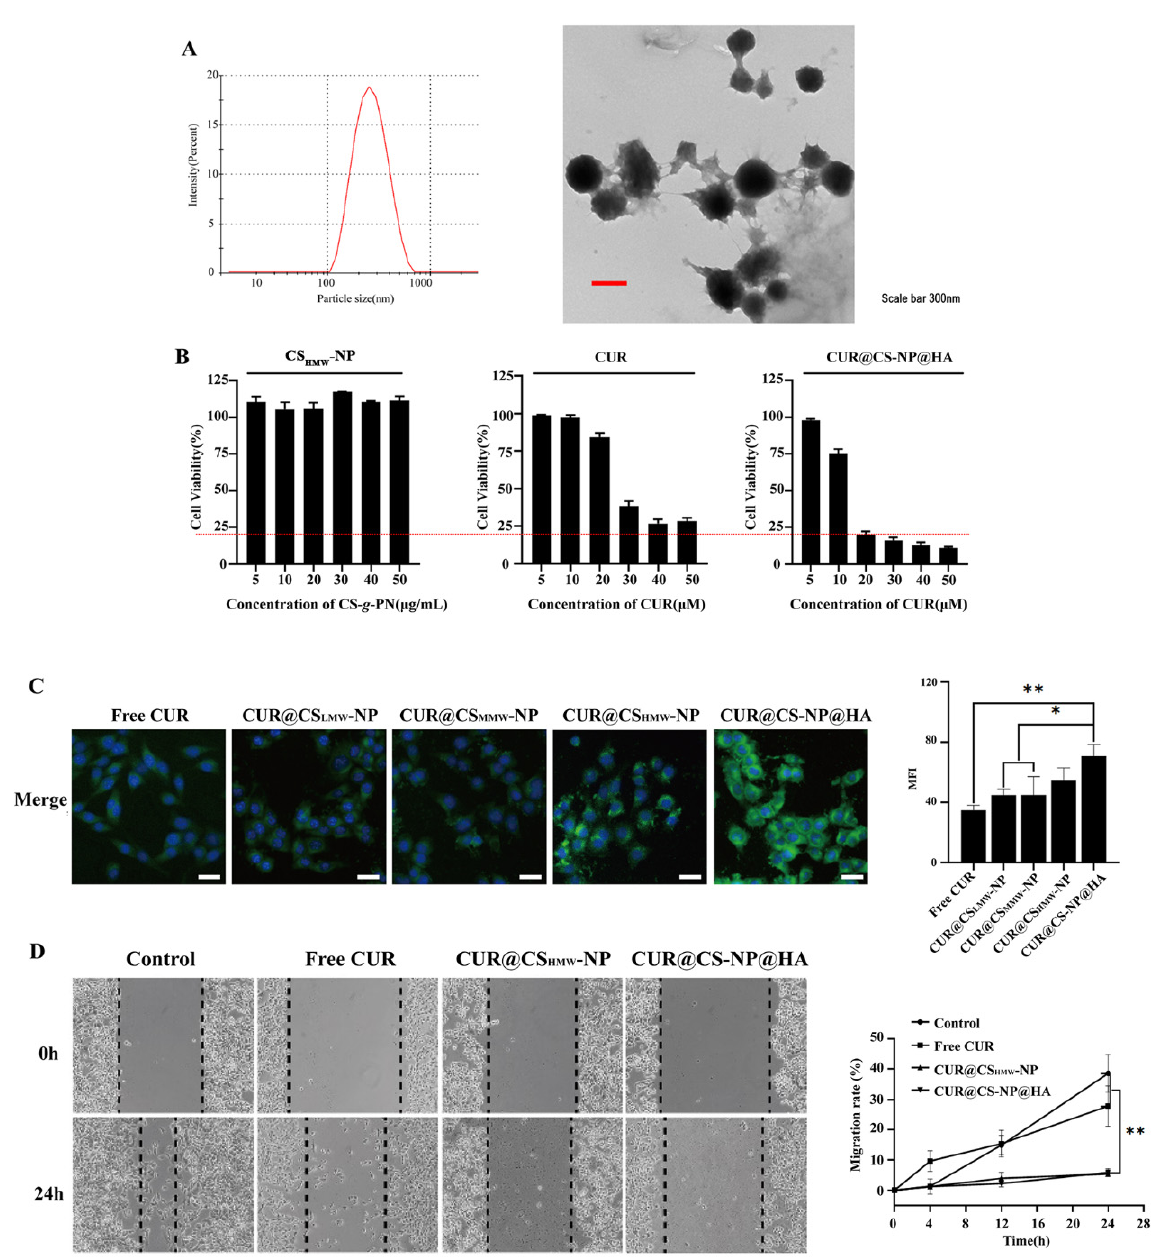
Figure 5. In vitro cell assay for the HA - anchoring NPs fabricated based on CS HMW - g - PN polymer. ( A ) Particle size distribution and TEM image of CUR@CS - NP@HA. ( B ) Cytotoxicity of vehicle con- trol, CUR, and CUR@CS - NP@HA. ( C ) Uptake of CUR by 4T1 cells (scale bar = 20 μ m) (* p < 0.05). ( D ) The migration of 4T1 cells treated with NPs (* p < 0.05; ** p < 0.01).